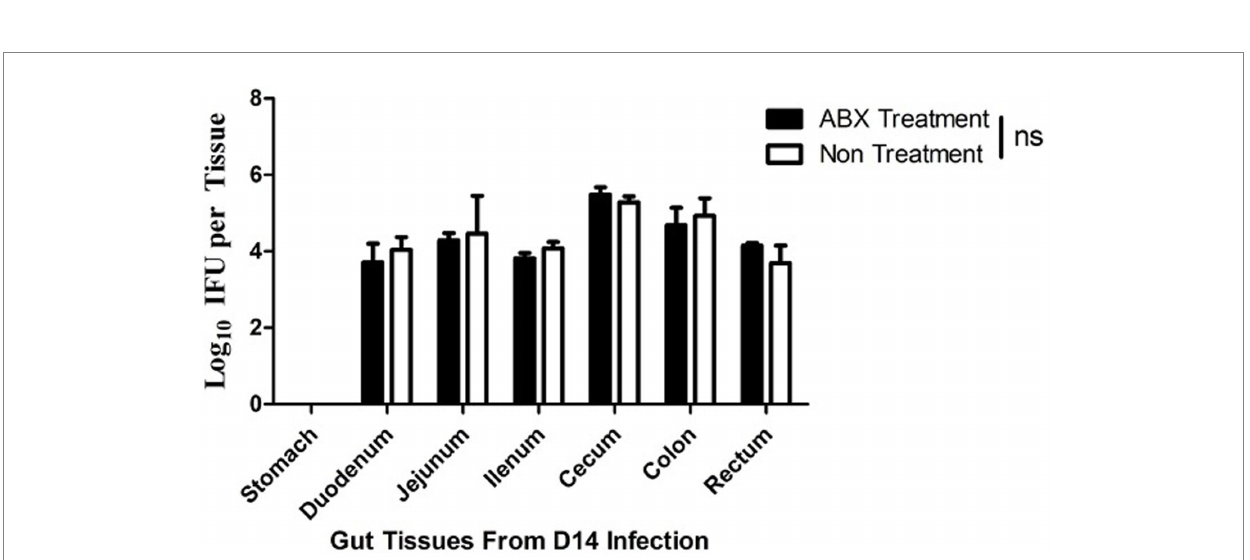
FIGURE 6 Oral antibiotics treatment fails to alter C. muridarum distribution in the mouse gastrointestinal tract. Female DBA2/J mice without (Non, n = 5) or with (ABX) oral antibiotics treatment for 21 days were intravaginally inoculated with C. muridarum as described in Figure 3 legend. On day 14 after the intravaginal inoculation, all mice were sacrificed for titrating live organisms recovered from different regions of the gastrointestinal tract including stomach, duodenum, jejunum, ilium, cecum, colon and rectum as shown along X -axis. The live organisms recovered were expressed as Log10 IFUs as shown along Y -axis. Note that live C. muridarum organisms were similarly detected in different regions of the gastrointestinal tracts from all mice regardless of the oral antibiotics treatment ( p > 0.05, Wilcoxon for comparing IFUs from individual tissues between the two groups of